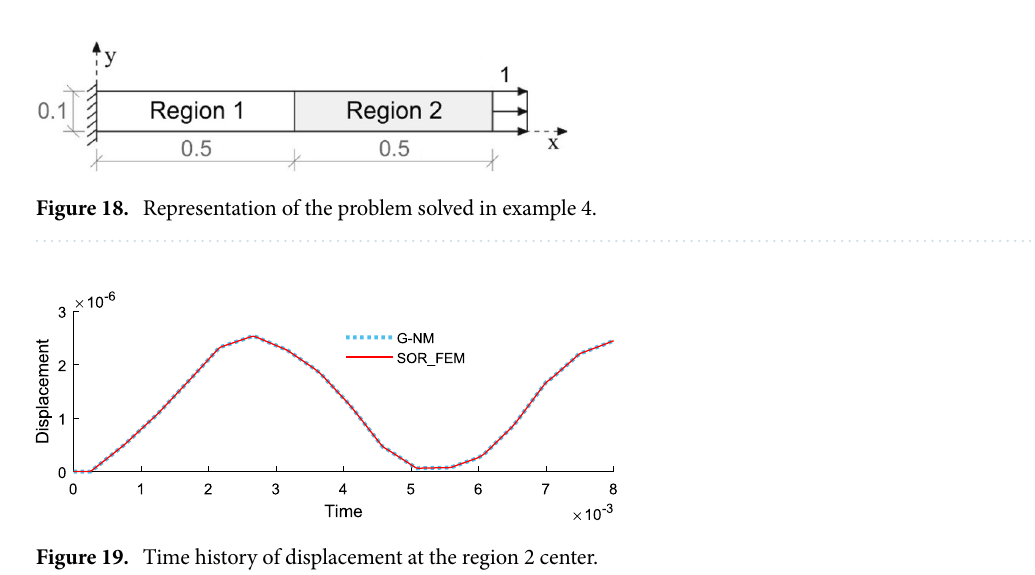
Figure 17. Relative error for velocities for different time step sizes and mesh refinements at time t = 0.005.